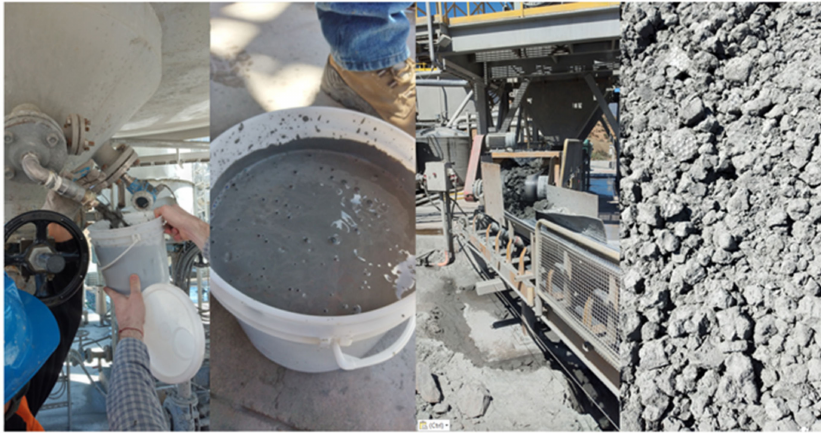
Figure 1. Tailings from the San Pedro mine, Til Til, Chile.